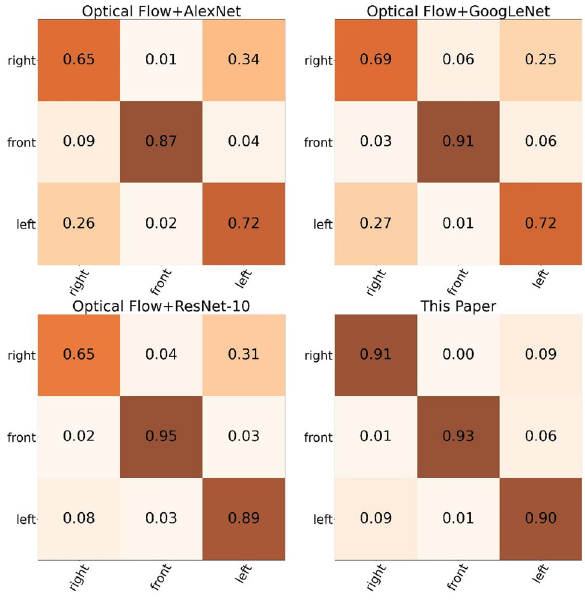
Fig. 16 Confusion matrices of various pedestrian orientation classifica- tion algorithms on PDRD data set